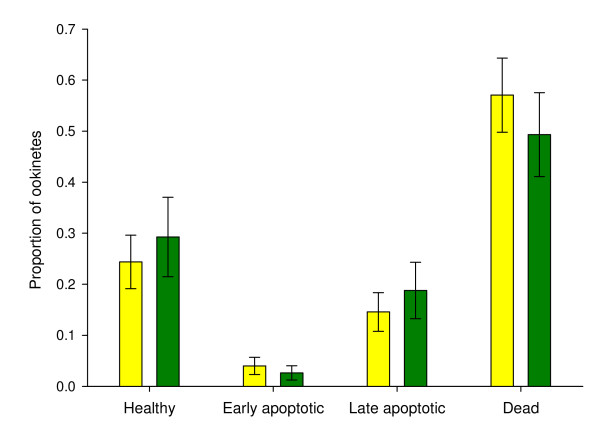
Between experiments markers of apoptosis and death are repeatable. Data taken from the experiments described in figure 4. Average proportion of ookinetes classified into 4 categories (healthy, early apoptotic, late apoptotic or dead) across 9 replicate infections for experiment 1 (yellow) and 10 replicate infections for experiment 2 (green). Although there is variation for replicate infections within experiments (figure 4) there is no significant variation between the cells categorised into each condition between 2 experiments carried out on different days (χ2 = 5.81 (3 df), p > 0.1). Error bars show the standard error of the mean.